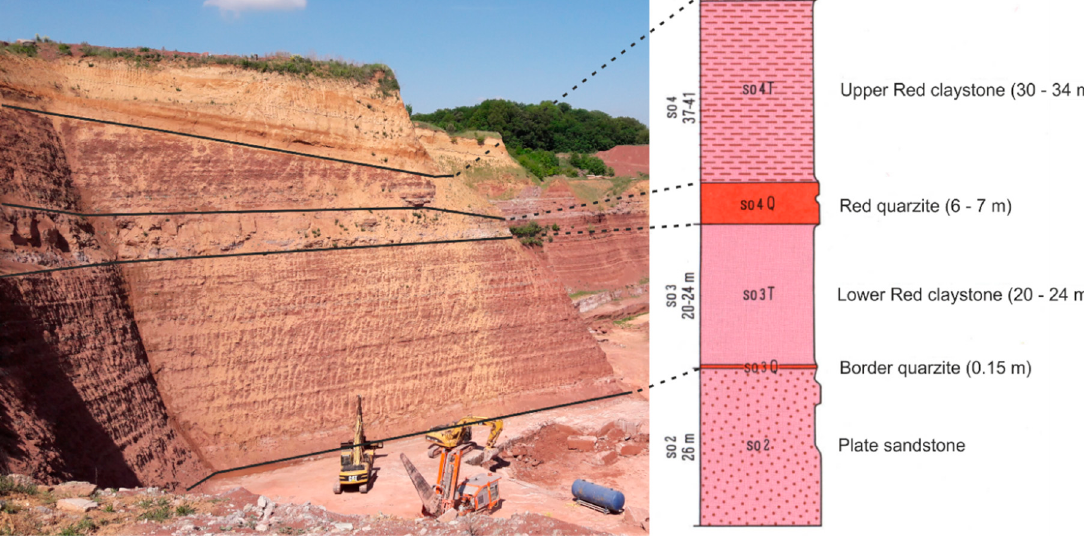
Figure 1. Quarry in Remlingen, where the specimens were taken with a stratigraphic profile of the upper Buntsandstein (layers after [42]).